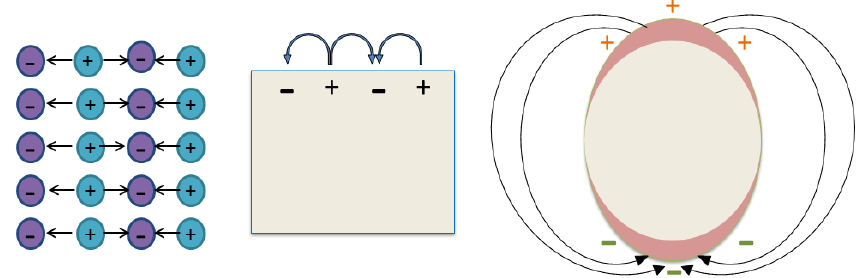
Figure 1. Three different oscillations. Adapted from Ref. [30]. Figure 1. Three di ff erent oscillations. Adapted from Ref. [30].